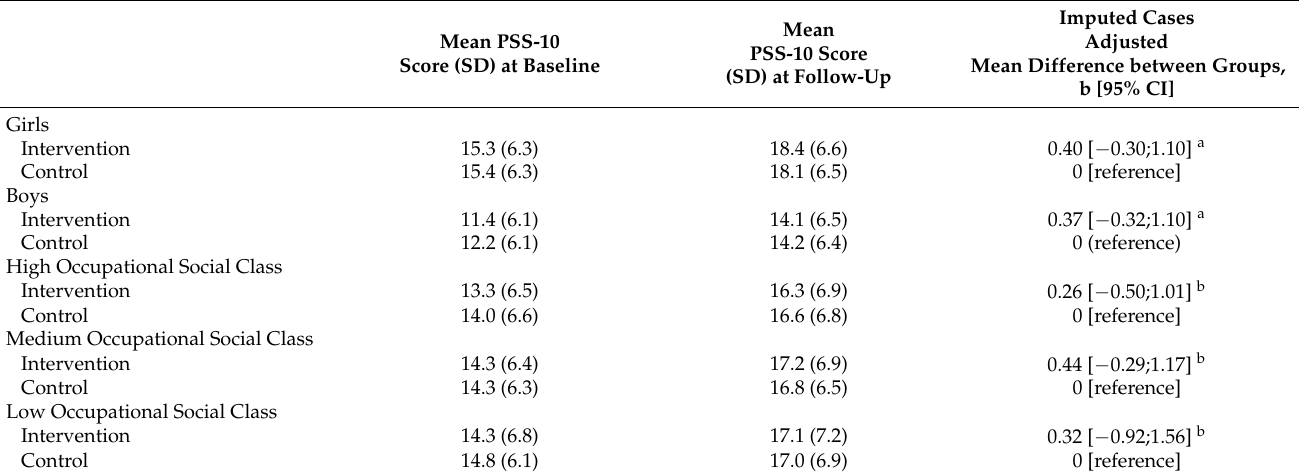
Table 4. Perceived stress (PSS-10 score) at baseline and follow-up, and effect of the Healthy High School intervention on perceived stress at 9-month follow-up stratified by gender and parental occupational social